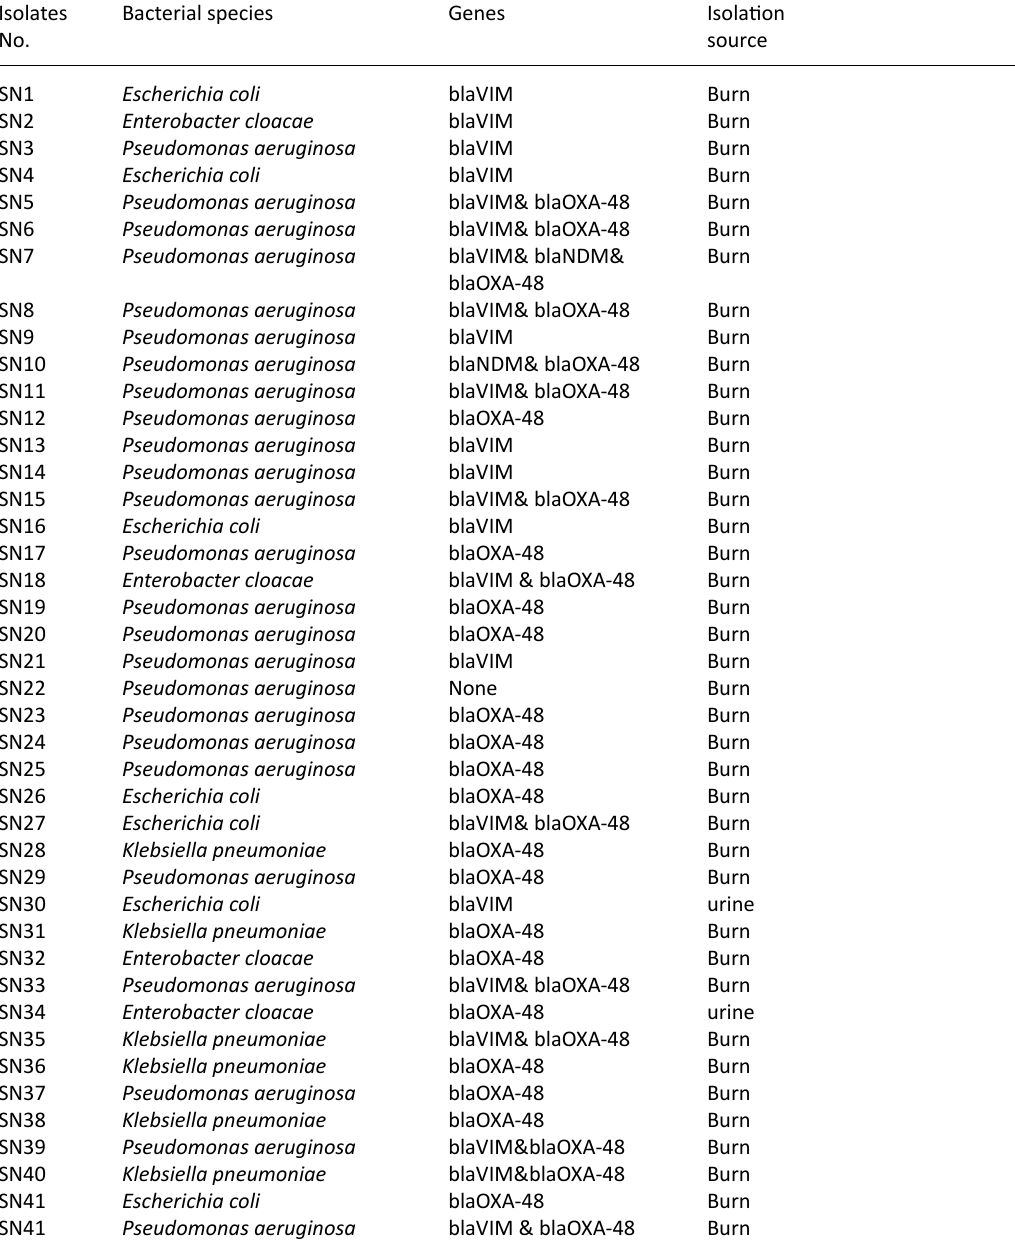
Table 2. Distribution of carbapenemases encoding genes among isolates Isolates Bacterial species Genes